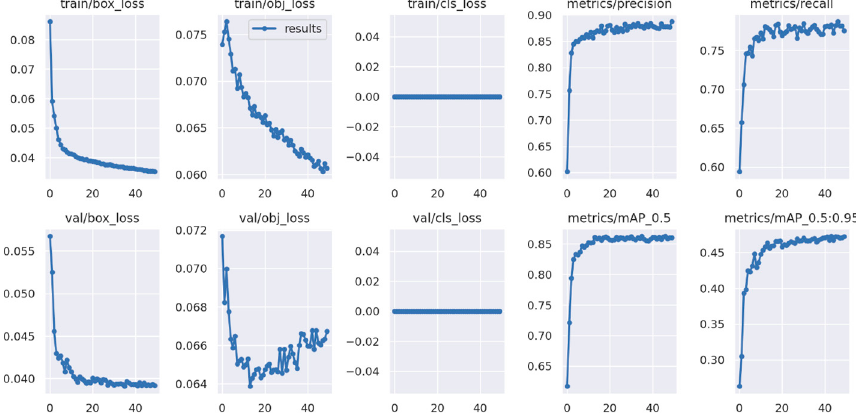
Figure 16. Training performance of datasets using the YOLOv5 algorithm.